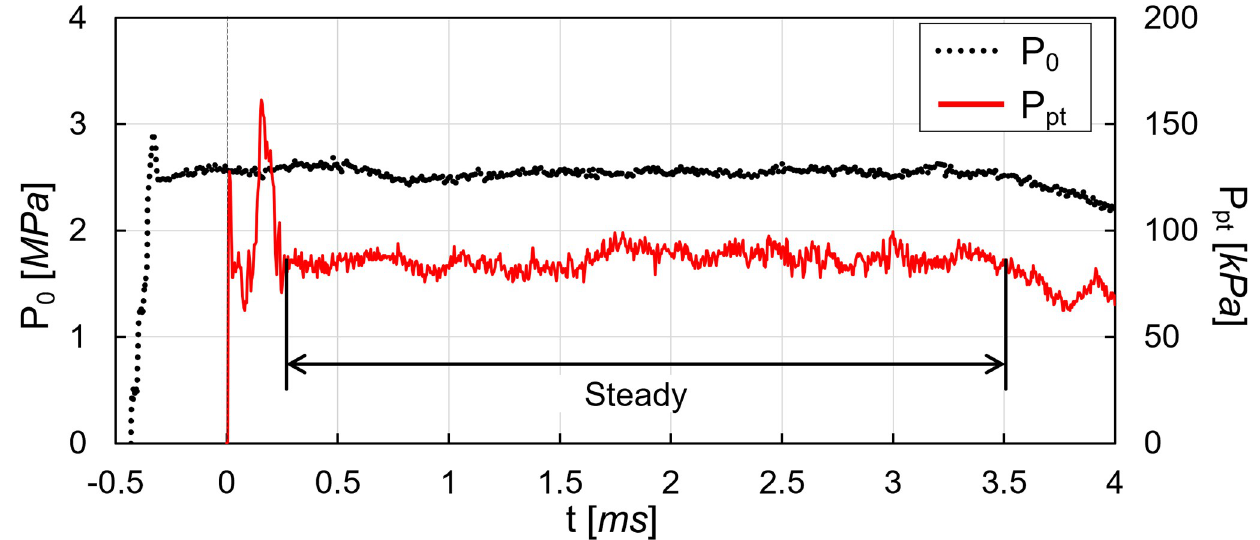
Fig 2. Typical measured pressure histories in K1 shock tunnel